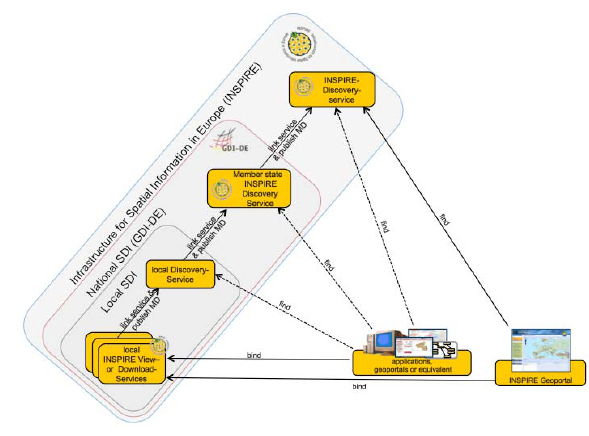
Figure 2. Example for linked discovery services in Germany (European Commission Joint Research Centre, 2009) View